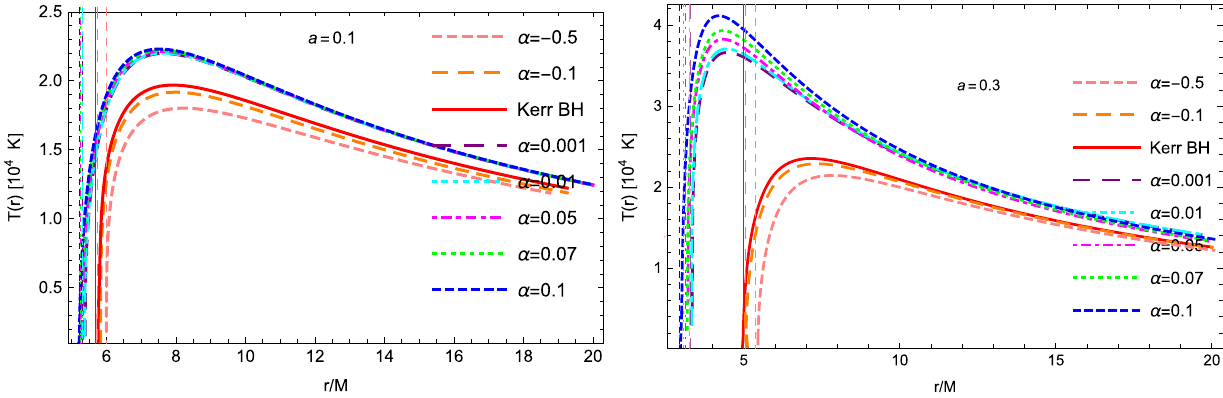
Fig. 5 The disk temperature T ( r ) for a rotating BH in EGB gravity with mass accretion rate ˙ M = 2 × 10 − 6 M (cid:8) yr − 1 , for different values of α . The rotation parameter is set to a = 0 . 1 (left panel) and a = 0 . 3